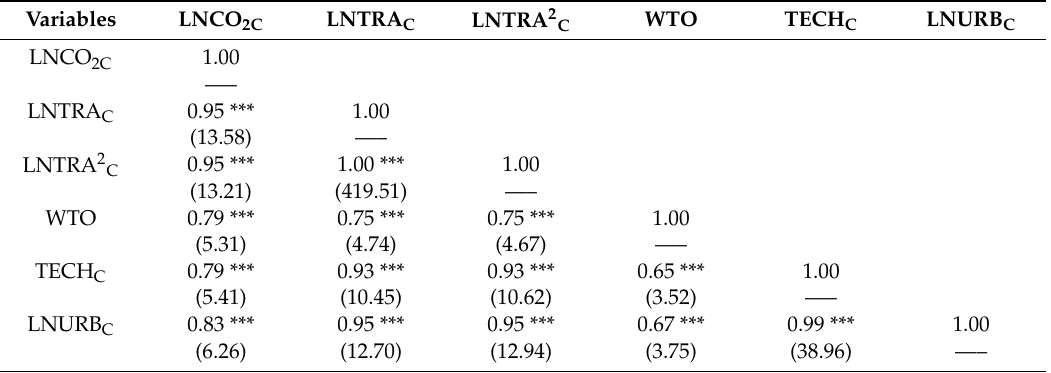
Table 3. Correlation analysis results for China.